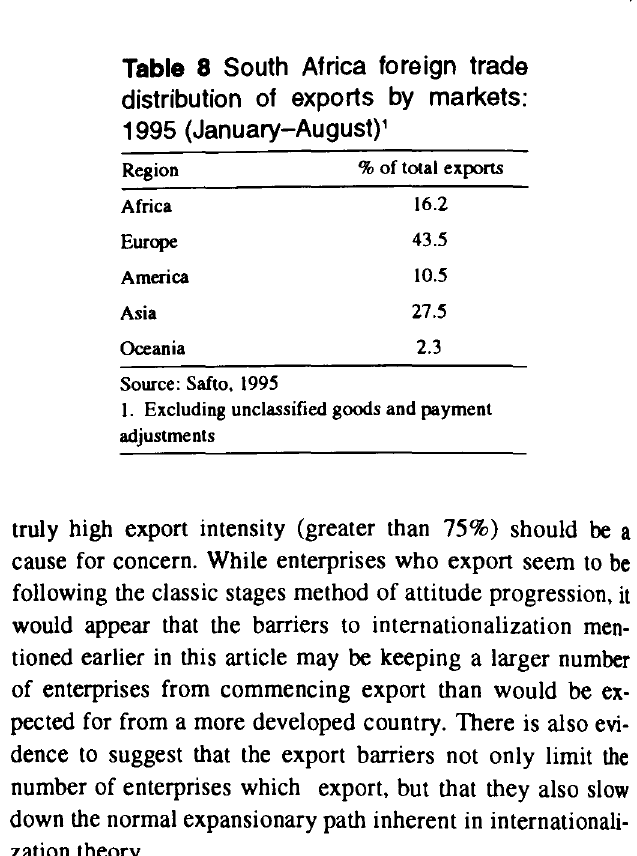
Table 7 South African exports by category: